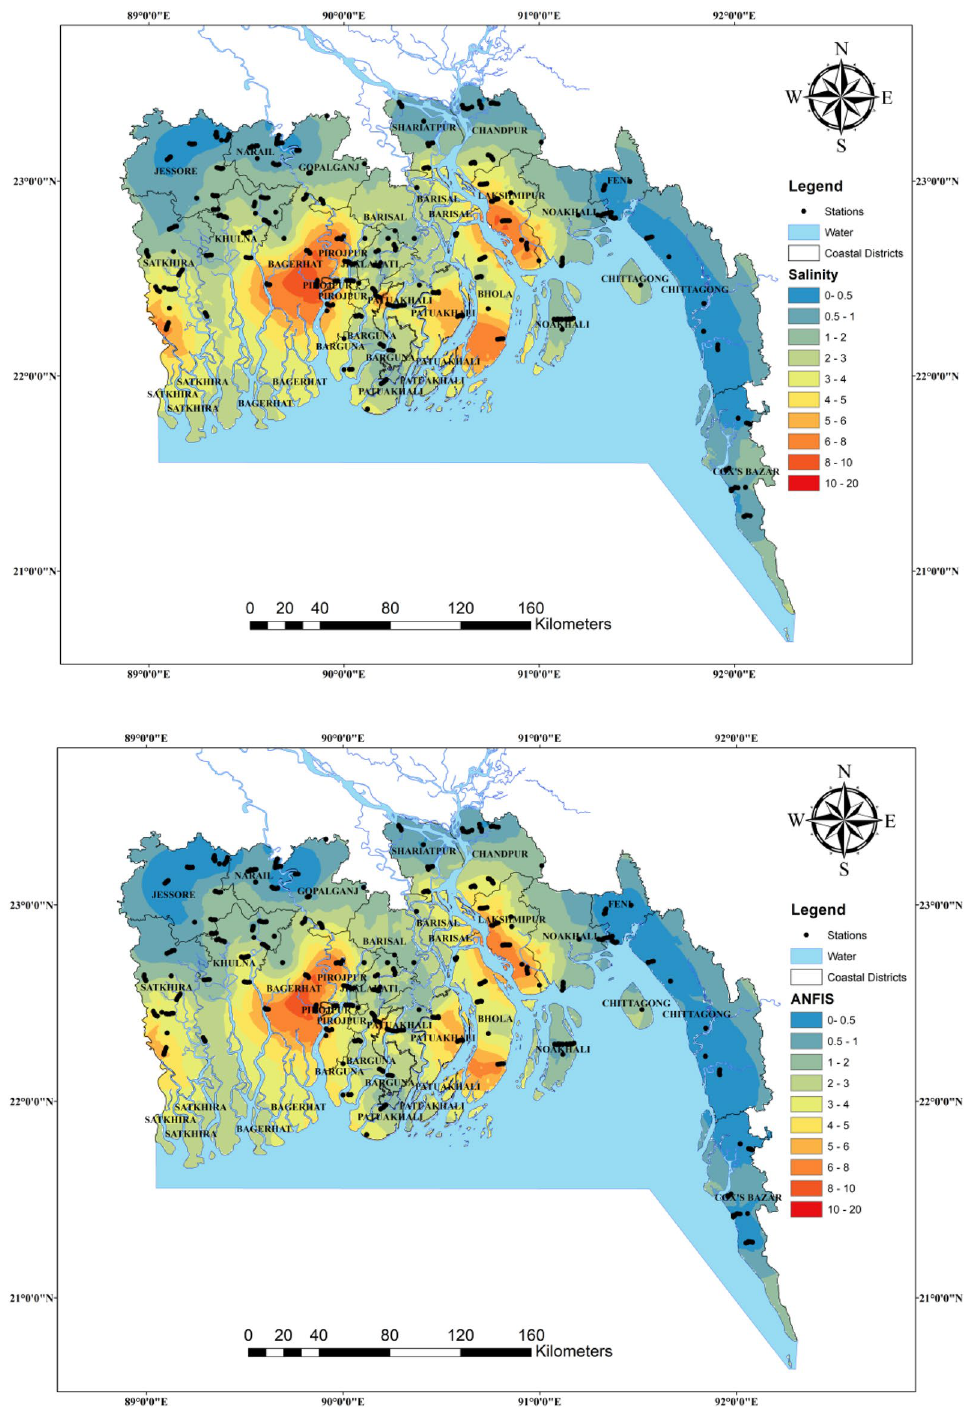
Figure 13. Salinity susceptibility maps for the groundwater samples collected from the coastal regions of during training and testing phases. The outputs yielded by the ML models were plotted about the 45° (1:1 line or best fit line—solid black line) along with relative error bands of 20% (dash-dot lines). Another metric i.e., ± R (coefficient of correlation) between observed versus predicted values of groundwater salinity in testing, was displayed to assess the effectiveness of the ML models. These figures show that the ANFIS model optimized with the OA algorithm has predicted groundwater salinity values close to the observed values or most of the predicted data centered towards the 1:1 line within 20% error bands in all scenarios. Furthermore, the highest value ±